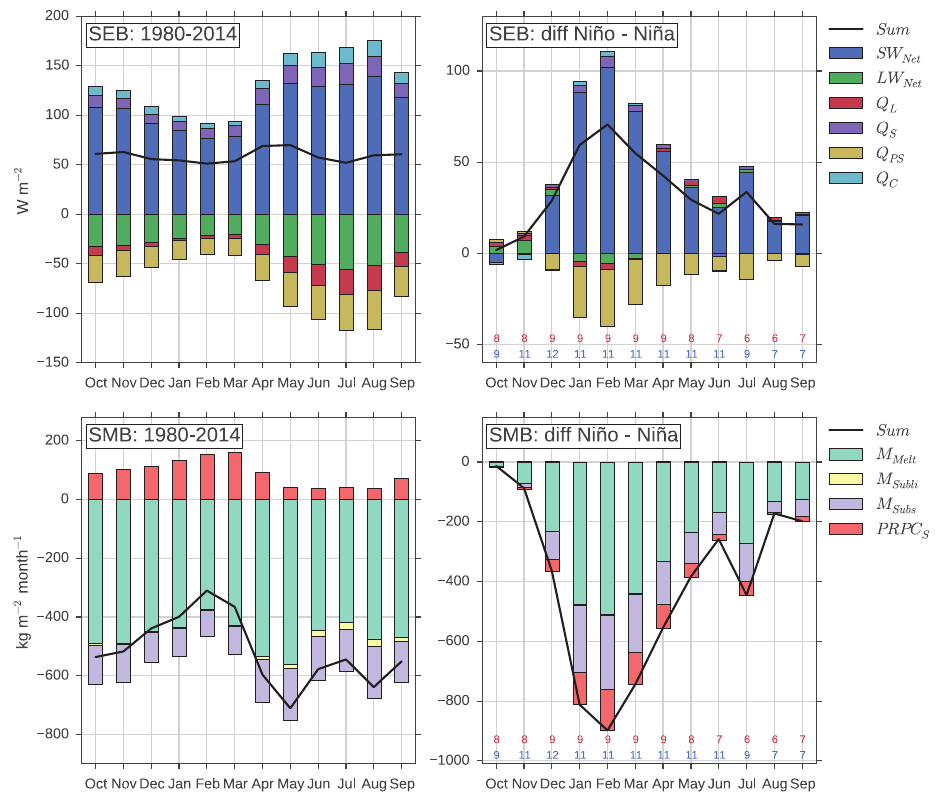
Figure 7. Annual cycles of the surface energy (top) and mass (bottom) fluxes at 4750ma . s . l . Left: 1980–2014 average. Right: average difference between the Niño and Niña composites. The numbers of values for the Niño (red) and Niña (blue) composites are indicated at the bottom of the plots. Note the different y axis ranges and that none of these differences is significant in the statistical sense because of the large standard deviation between years combined with the small number of composites and the variables’ RMSE.